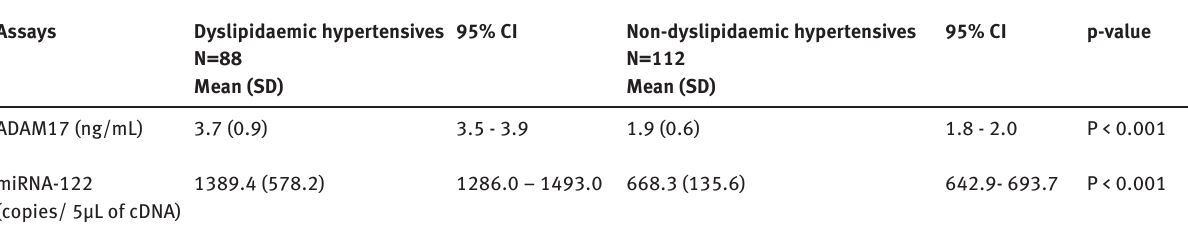
Table 3: Assay Values of Dyslipidaemic and Non-dyslipidaemic Hypertensive. Dyslipidaemic hypertensives had significantly higher values of miRNA-112 and ADAM17 when compared with non-dyslipidaemic hypertensives.